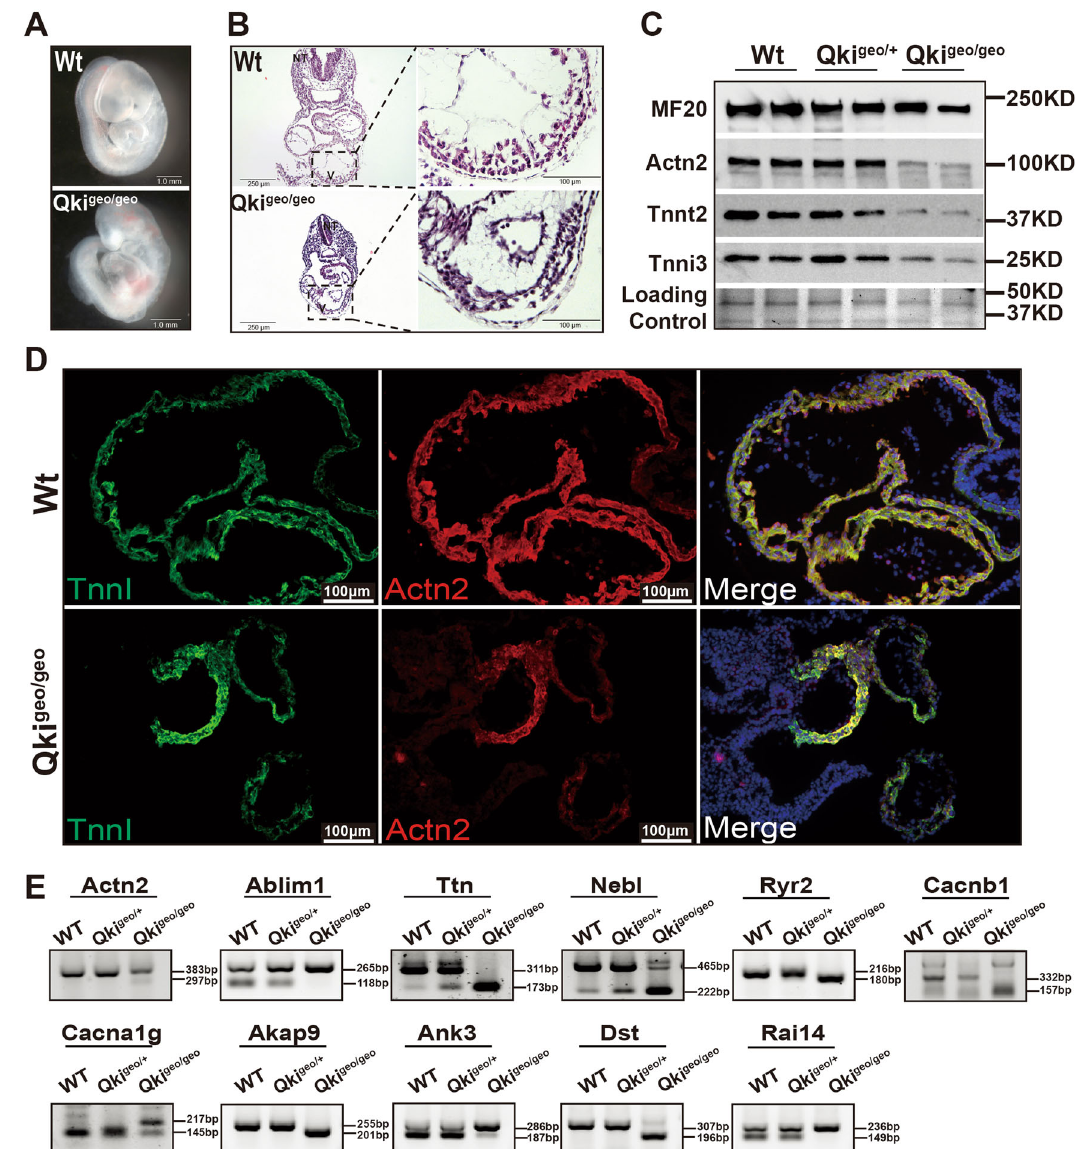
Fig. 9 Defects in myo fi brillogenesis in Qki β Geo/ β Geo mouse embryonic hearts. A Compared to wild-type littermates, Qki β Geo/ β Geo embryos at E9.5 are growth compromised with signi fi cant pericardial effusion, suggesting embryonic heart failure. Scale bar: 1.0 mm. B Histological analysis of Qki β Geo/ β Geo and littermate control embryos and hearts demonstrates thin ventricular wall with a signi fi cantly reduced level of trabeculation in Qki β Geo/ β Geo ventricles. Scale bar: 100 μ m. C Western blotting examination shows the expression of key sarcomeric proteins (myosin heavy chain, Actn2, Tnnt2, and Tnni3), which reveals signi fi cant downregulation of Actn2, Tnnt2, and Tnni3 in Qki β Geo/ β Geo hearts, which is similar to what was seen in cardiomyocytes derived from hESC- QKI del . D Representative images of immuno fl uorescence staining of TnnI3 and Actn2 in Qki β Geo/ β Geo and wild-type littermate control embryos at E9.0 show the severe defect in myo fi brillogenesis in Qki β Geo/ β Geo hearts. Scale bar: 100 μ m. E Representative RT-PCR results con fi rming alternative splicing events in Qki β Geo/ β Geo hearts (E9.25). All experiments are independently repeated at least three times with multiple different sets of samples to ensure the reproducibility of the fi